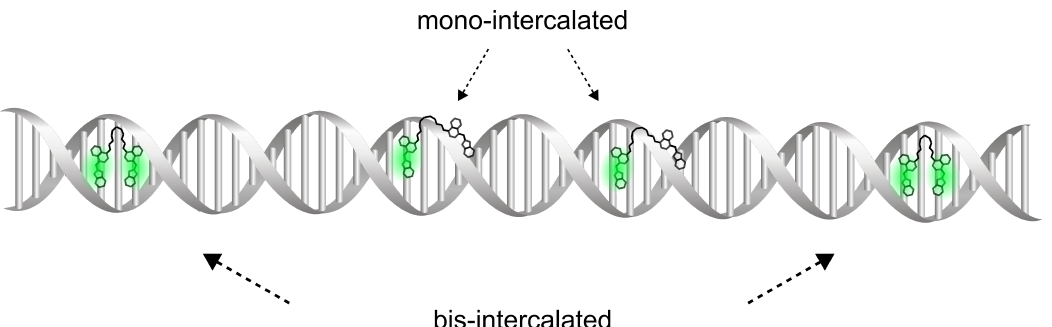
Figure 2. Scheme of two binding models of YOYO-1 to DNA. The complex can be formed by intercalating mer of YOYO-1 molecule to DNA, while the second mer is electrostatically bound along the helix (mono-intercalated YOYO-1) or intercalated (bis-intercalated YOYO-1). Different molecular brightnesses characterise each binding mechanisms.